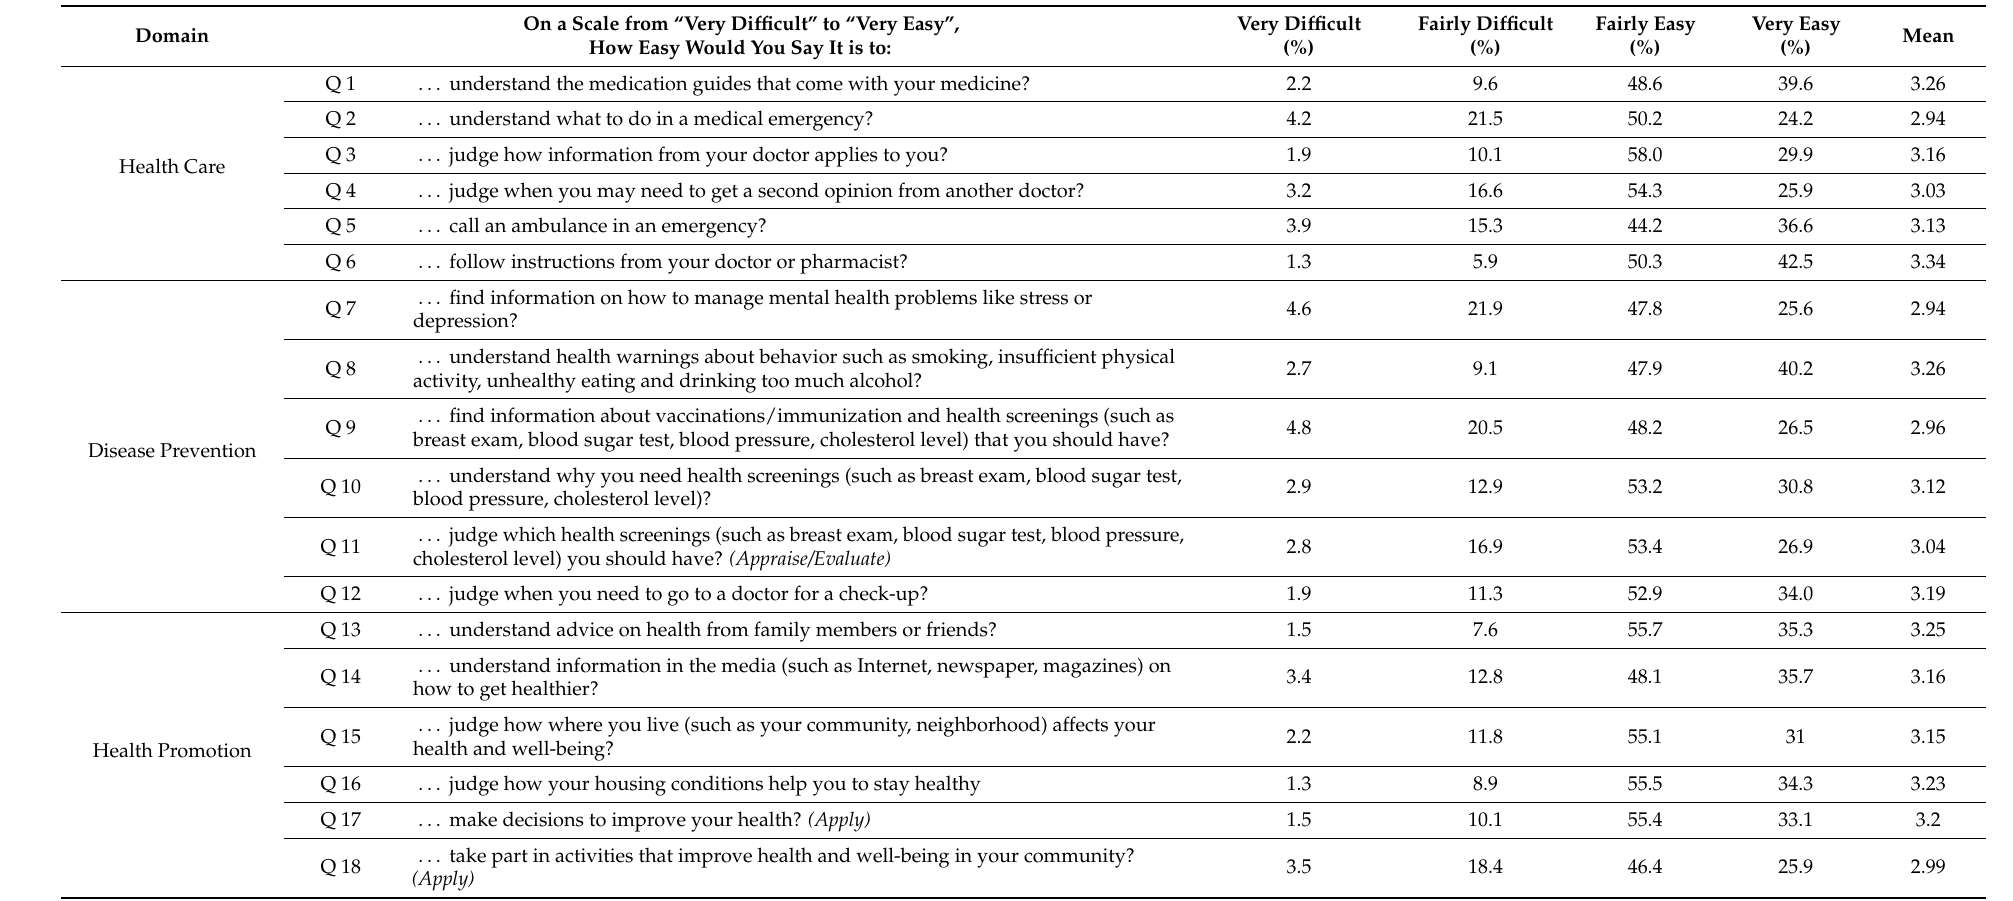
Table 3. Frequency table for health literacy (HLS-M-Q18)